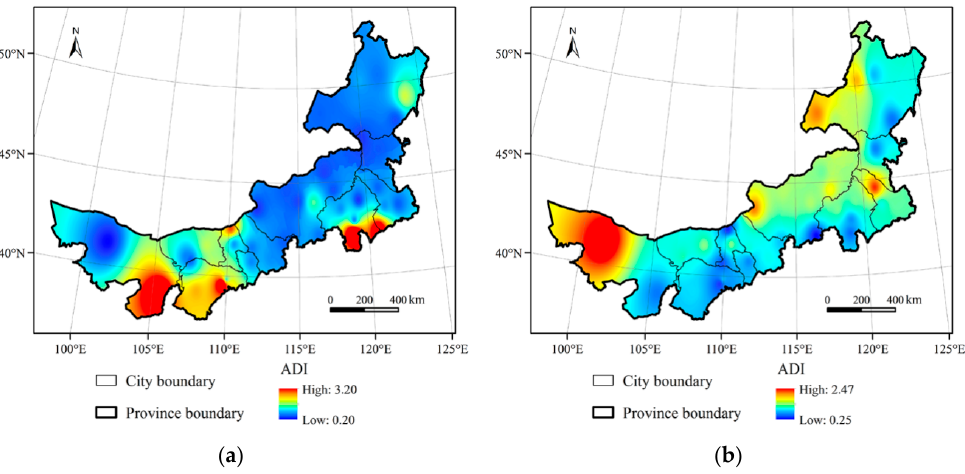
Figure 12. The spatial distribution of ADI values in ( a ) 1958–1992 and ( b ) 1993–2019.